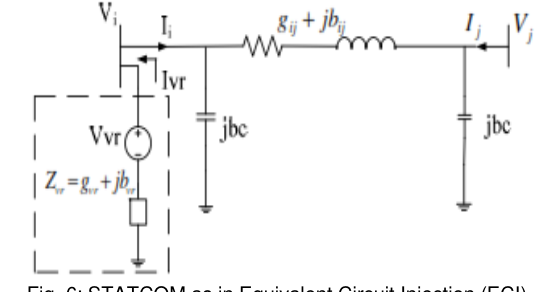
Fig. 6: STATCOM as in Equivalent Circuit Injection (ECI)